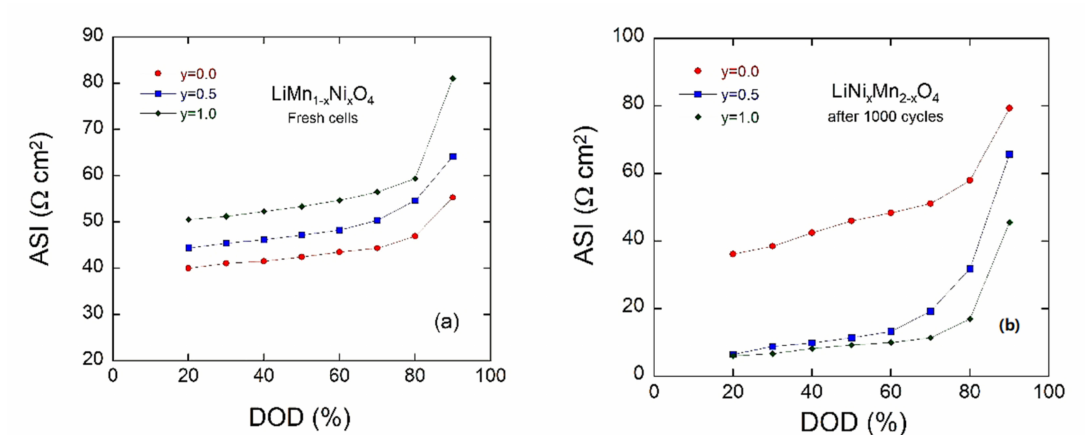
Figure 10. Area specific impedance (ASI) of parent and Ni-doped LiMn 2 O 4 as a function of depth of discharge (DOD) ( a ) before and ( b ) after 1000